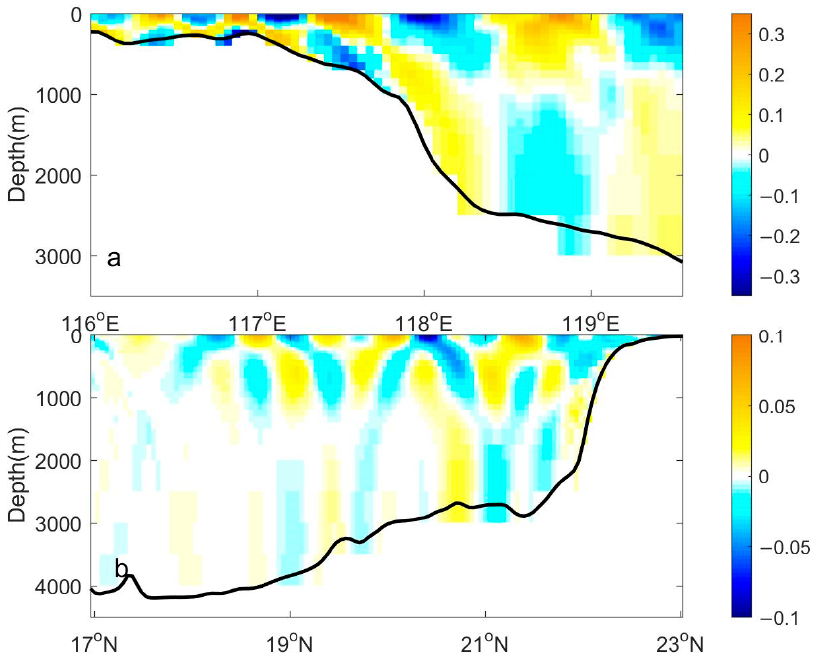
Figure 6. Snapshots of ( a ) the zonal baroclinic currents along 21° N and ( b ) the meridional baroclinic currents along 119° E (shading, unit: m/s) at the end of the simulation.